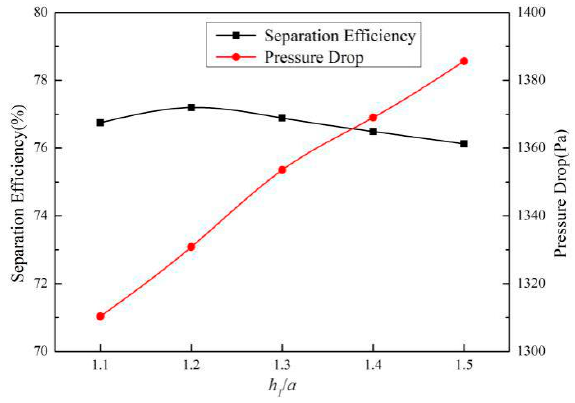
/ a ) on e ffi ciency and pressure 1